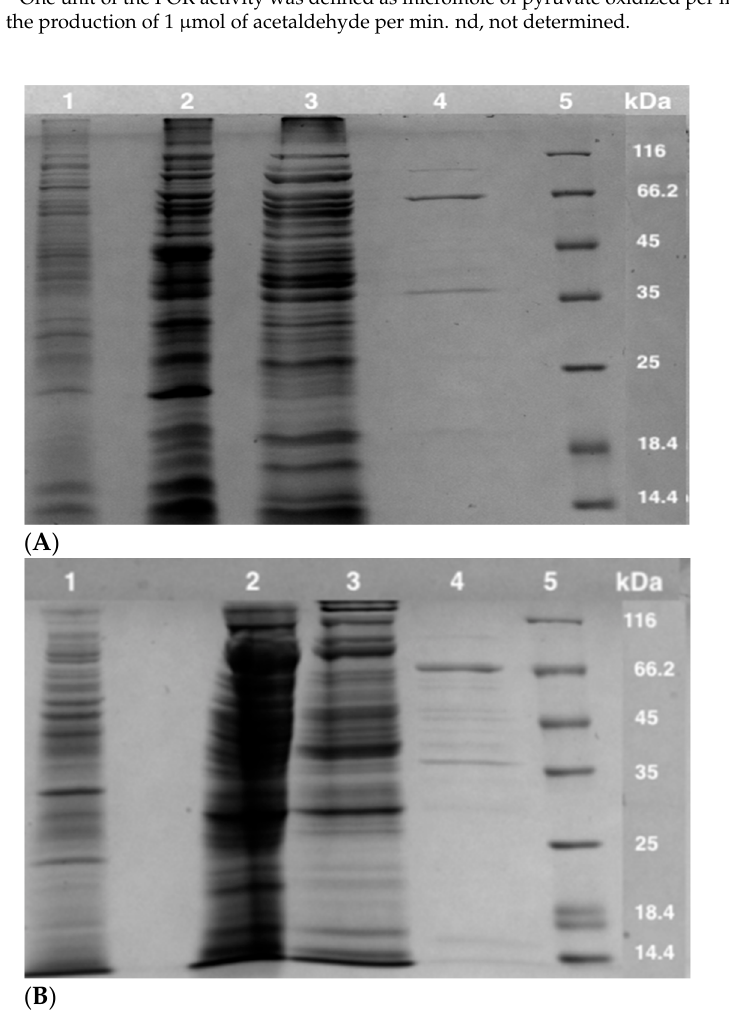
Figure 2. Analyses of purified bifunctional POR/PDCs from S. solfataricus ( A ) and S. acidocaldarius ( B ) using SDS-PAGE (12.5%). ( A ) Lane 1, 10 µ g of CFE; lane 2, 20 µ g of DEAE fraction; lane 3, 18 µ g of HAP fraction; lane 4, 1.5 µ g of purified enzyme; lane 5, BLUeye pre-stained protein ladder. ( B ) Lane 1, 12 µ g of CFE; lane 2, 33 µ g of DEAE fraction; lane 3, 22 µ g of HAP fraction; lane 4, 0.8 µ g of purified enzyme; lane 5, BLUeye pre-stained protein